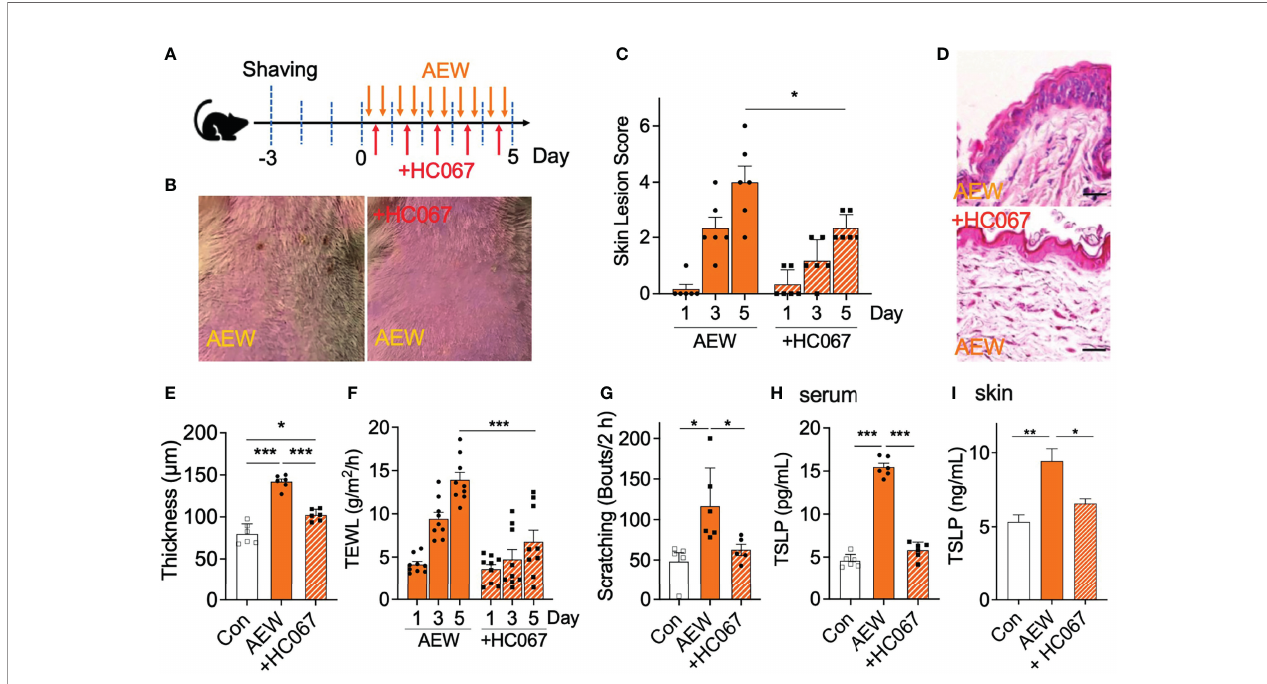
FIGURE 3 | Treatment with a TRPV4 antagonist alleviated the dry skin symptoms of AEW-treated mice. (A) A schematic illustration depicting the administration of HC067047 (HC067) during treatment with AEW. (B) Pretreatment with HC067 alleviated the deterioration in the overall skin conditions following AEW treatment. (C) The skin lesion scores signi fi cantly reduced in the HC067-treated AEW mice on day 5 (n = 6). (D) Representative H&E-stained images of the skin lesions of AEW- treated mice with or without HC067 administration. (E) The thickness of the epidermis signi fi cantly decreased in the skin lesions of the HC067-treated AEW mice (n = 6), compared to that of the control (n = 6) (F) The values of TEWL signi fi cantly reduced in the HC067-treated AEW mice on day 5 (n = 9), compared to those of the control (n = 9). (G) The spontaneous scratching bouts were reduced in the HC067-treated AEW mice (n = 5), compared to those of the control (n = 6). (H) The serum levels of TSLP signi fi cantly decreased in the HC067-treated AEW mice (n = 6), compared to those of the control (n = 6). (I) TSLP in the skin signi fi cantly decreased in HC067-treated AEW mice (n = 6) compared to the AEW-treated mice (n = 6). * p < 0.05, ** p < 0.01, *** p <